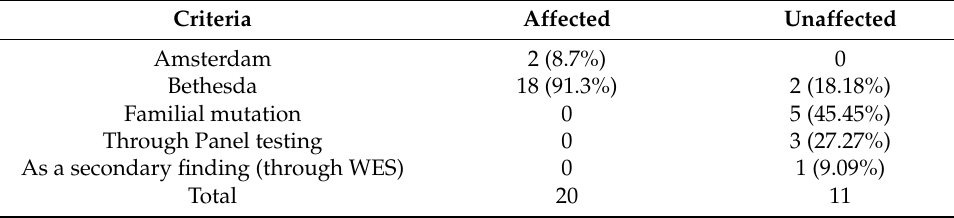
Table 8. Summary of criteria of selection of Affected and unaffected